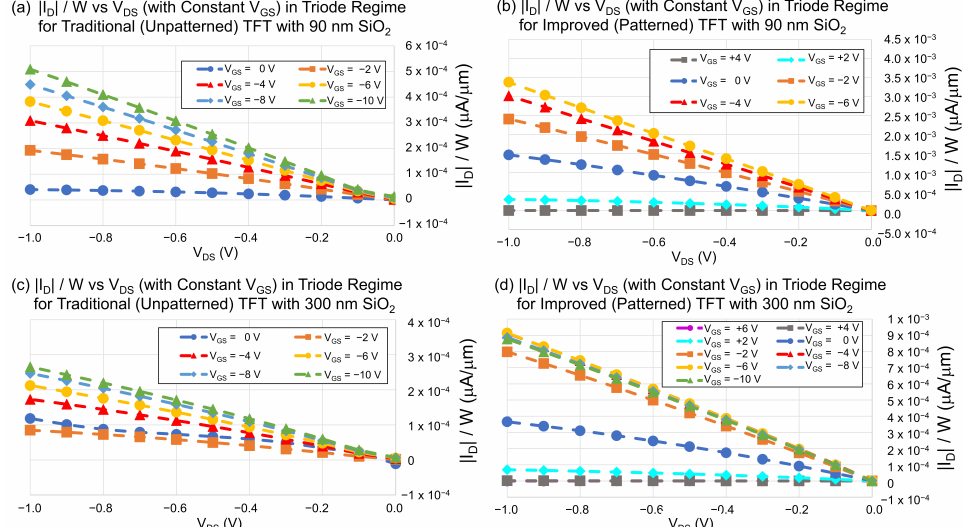
Figure 4. |I D |/W versus V DS characteristics in the triode regime of the: ( a ) traditional (unpatterned) TFT with a 90 nm SiO 2 , ( b ) improved (patterned) TFT with a 90 nm SiO 2 , ( c ) traditional (unpatterned) TFT with a 300 nm SiO 2 , and ( d ) improved (patterned) TFT with a 300 nm SiO 2